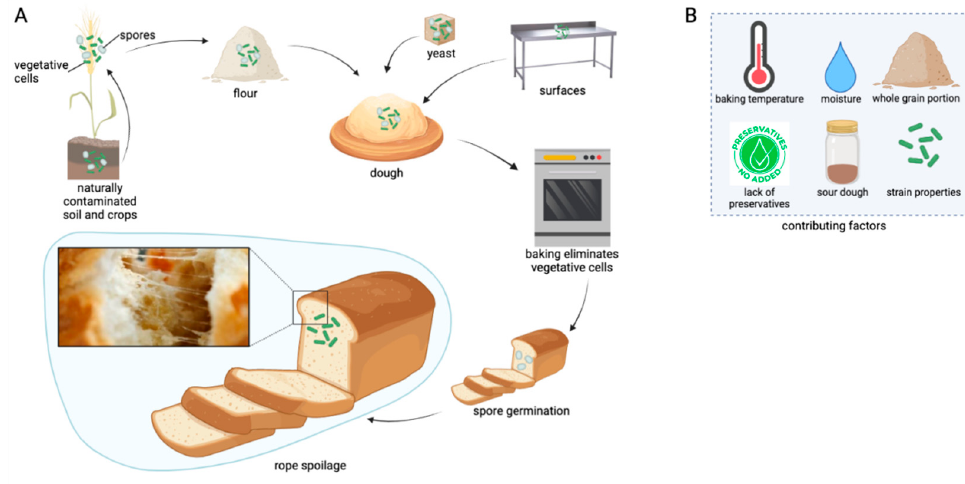
Figure 2. The route of endospores into bread ( A ) and influencing factors for the development of rope spoilage ( B ). Created with BioRender.com.